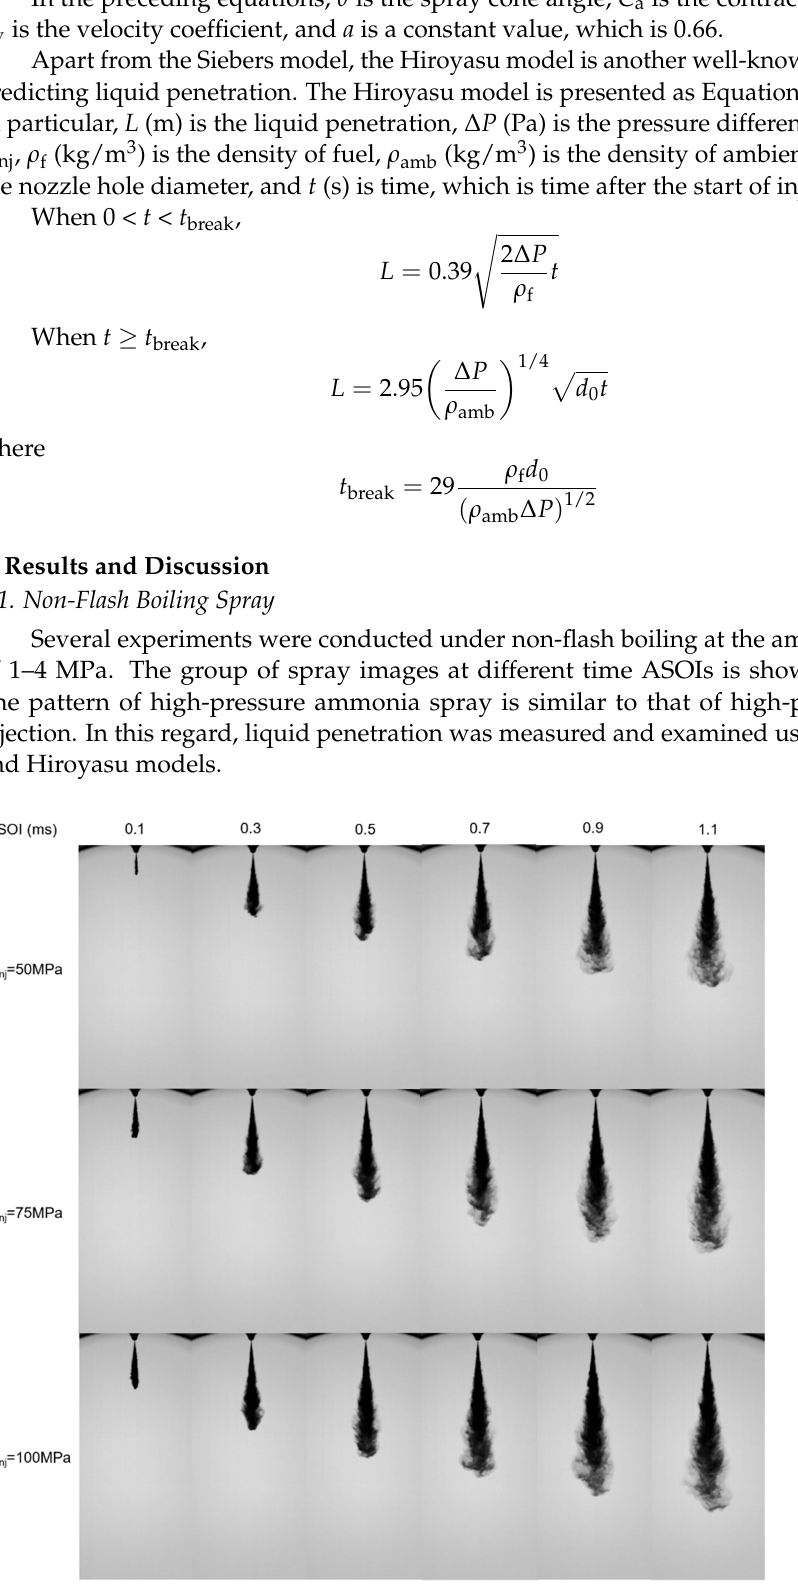
Figure 3. Spray images at different injection pressures, P amb = 4 MPa. Fuel: liquid ammonia.